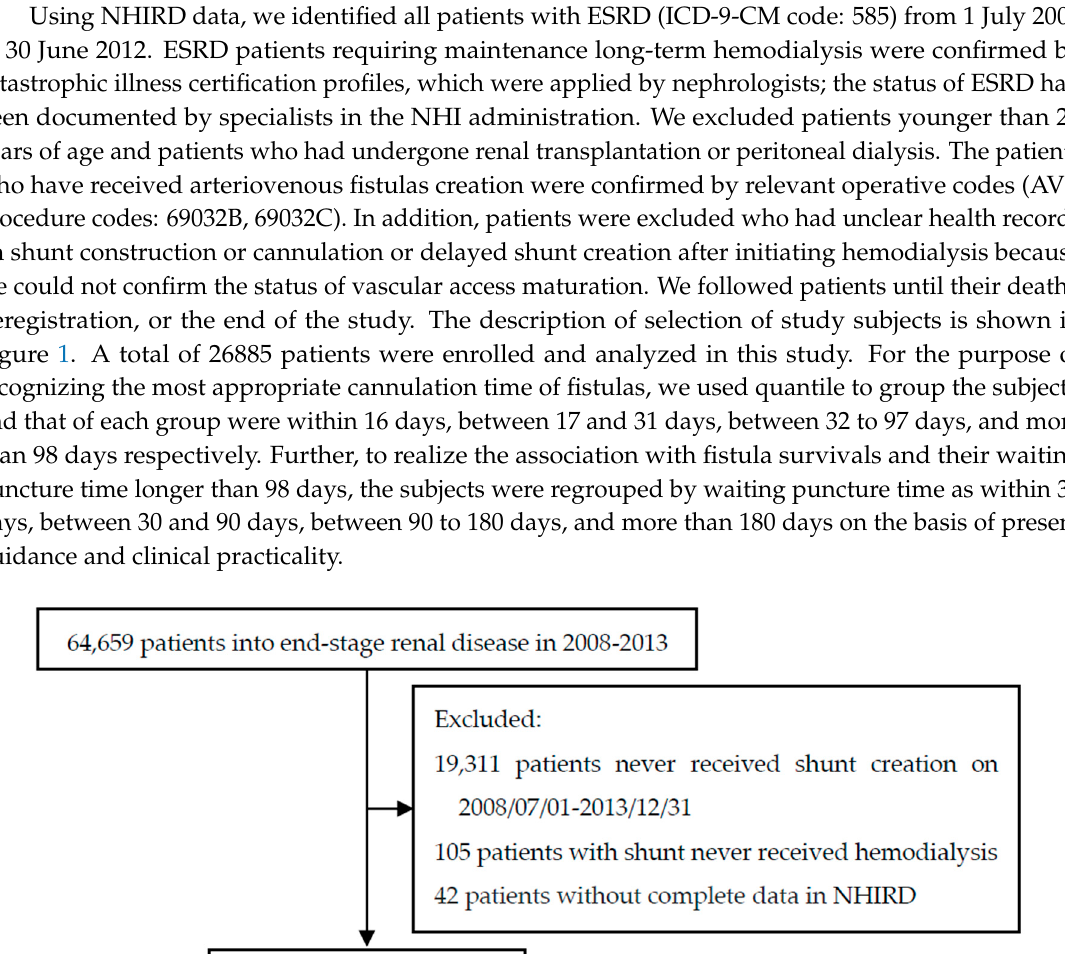
Figure 2. Definitions of shunt survival. a Functional maturation: shunt is cannulated for hemodialysis successfully